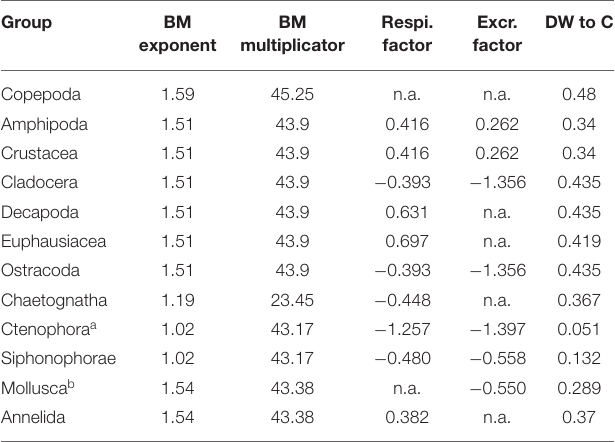
TABLE 2 | Conversion factors and functions used in this publication.